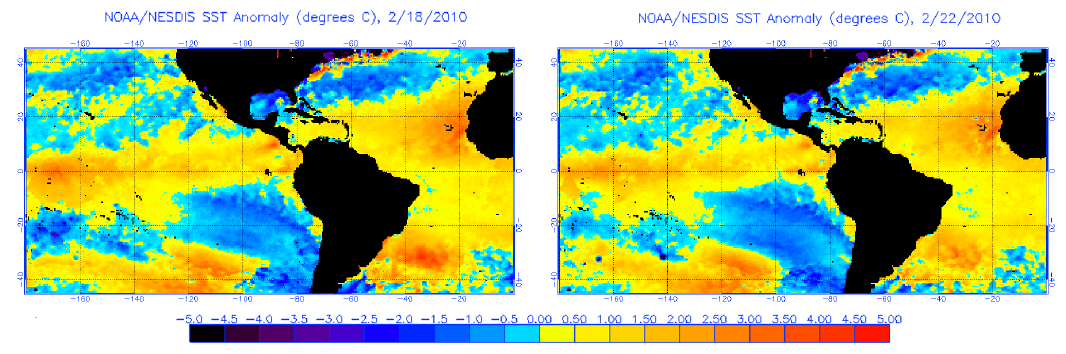
Fig. 12. Time evolution of equivalent potential temperature lapse rate over Funchal (windward), Areeiro (crest) and S. Jorge (lee side).